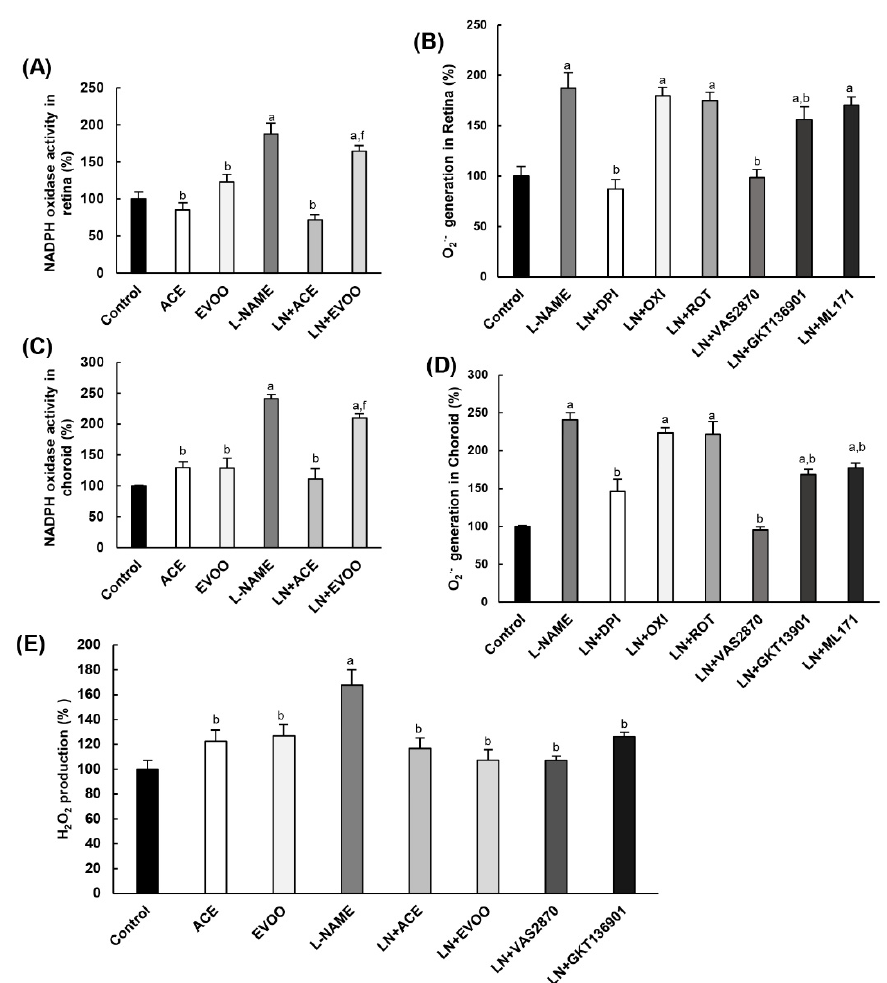
Figure 4. ( A ) Relative NADPH oxidase activity in retina homogenates and ( B ) characterization of the primary source of superoxide anion via preincubation with di ff erent inhibitors, as specified in Section 2.7. ( C , D ) Similar experiments as in ( A , B ) were performed in choroid homogenates. ( E ) H 2 O 2 levels, measured by Amplex Red assay, in retina homogenates from all six experimental groups, including the e ff ect of specific NOX inhibitors on L-NAME-treated animals. Values are expressed as mean ± SEM of four animals per group: a p < 0.05 vs. control; b p < 0.05 vs. L-NAME; f p < 0.05 vs. LN +